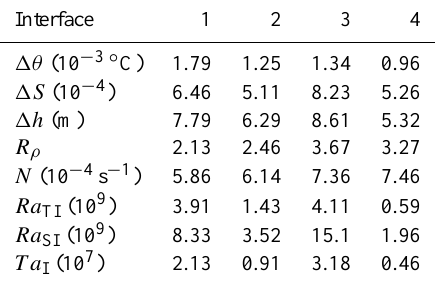
Table 1. Mean properties of four diffusive interfaces at Mooring A between 2 October 2009 and 9 August 2010. They are potential temperature difference, 1θ , salinity difference, 1S , thickness, 1h , density ratio, R ρ , buoyancy frequency, N , thermal Rayleigh num- ber, Ra TI , salinity Rayleigh number, Ra SI , and Taylor number, T a I .